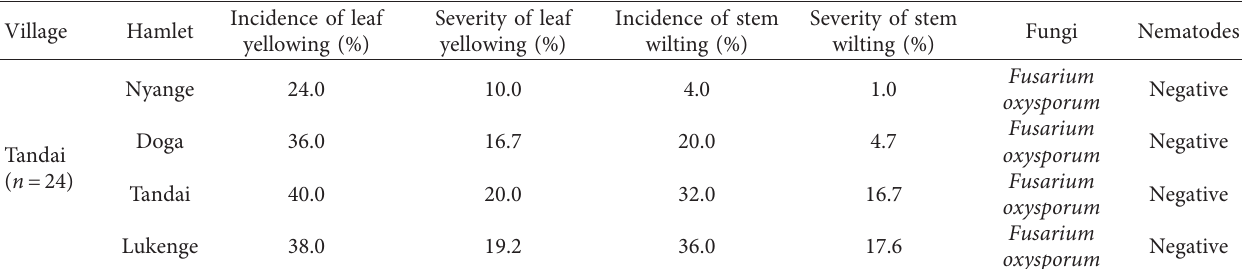
Figure 3: Percentage of affected plants with respect to the number of wilted internodes on the pepper stem. Table 3: Occurrence of leaf yellowing, stem wilting, and the prevalent